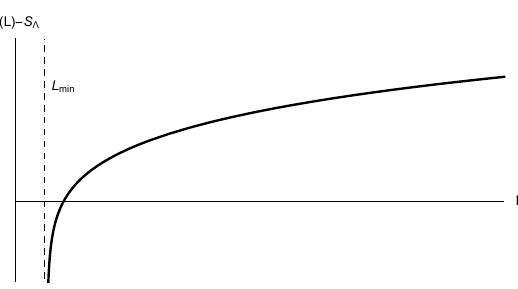
Figure 5 . S ( L ) − S Λ vs. L plot for the case c 1 = 0 . This quantity is independent of the cutoff and asymptotes to −∞ as L → L min . To generate this plot we have chosen ε + = 0 . 35